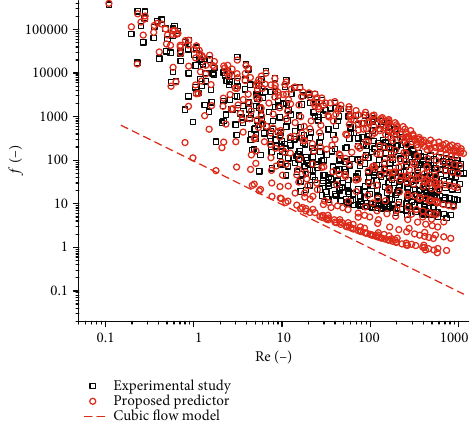
Figure 17: Comparison of predicted and experimentally measured friction factor